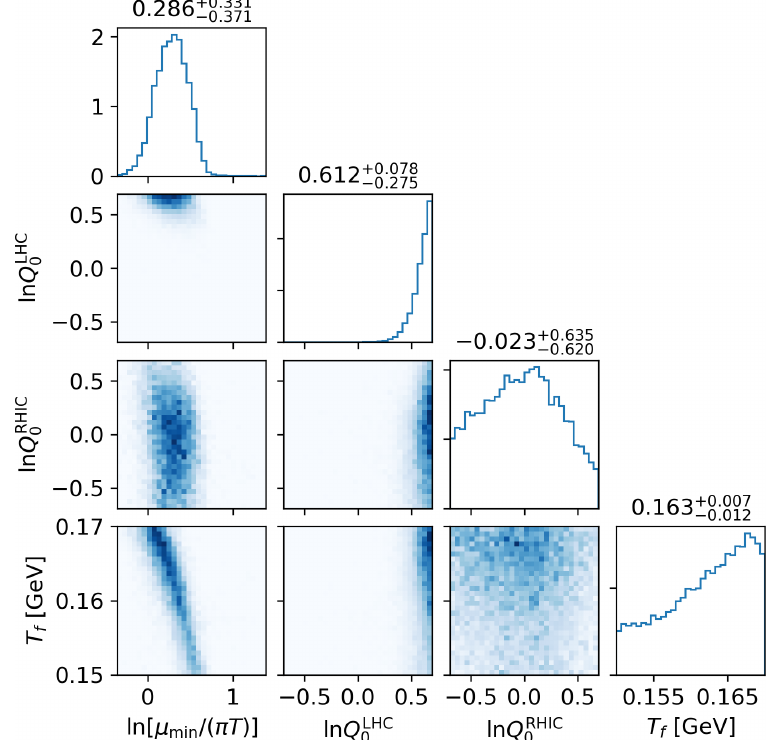
Figure 3 . The posterior probability distribution of model parameters. Each diagonal plot shows single-parameter distribution after model-to-data comparison. Each off-diagonal plot corresponds to a two-parameter joint distribution. Numbers at the top of each diagonal plot are the median values with upper and lower uncertainties of each parameter, defined as the 95.7% and 2.5% quantile number of the one-parameter marginalized